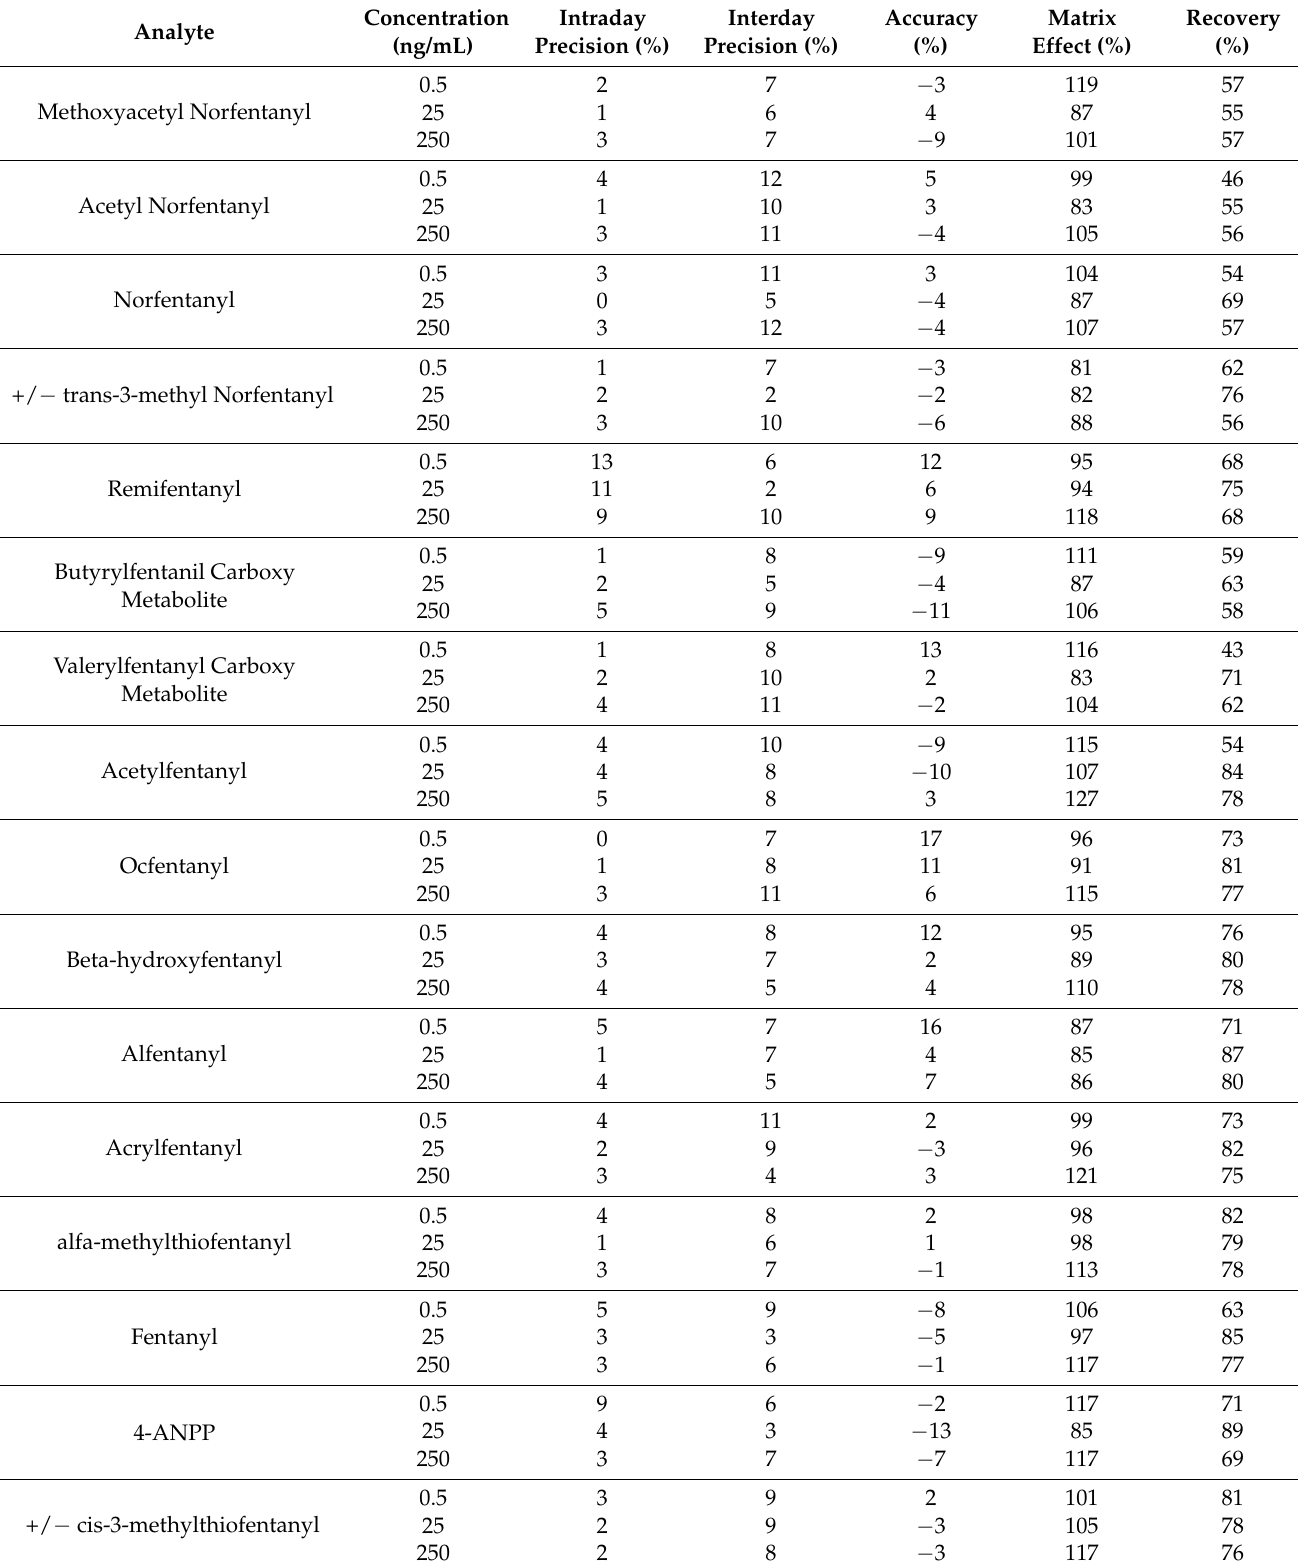
Table 2. Validation data; intraday precision, interday precision, accuracy, matrix effect and recoveries calculated at the selected three concentrations, 0.5, 25 and 250 ng mL − 1